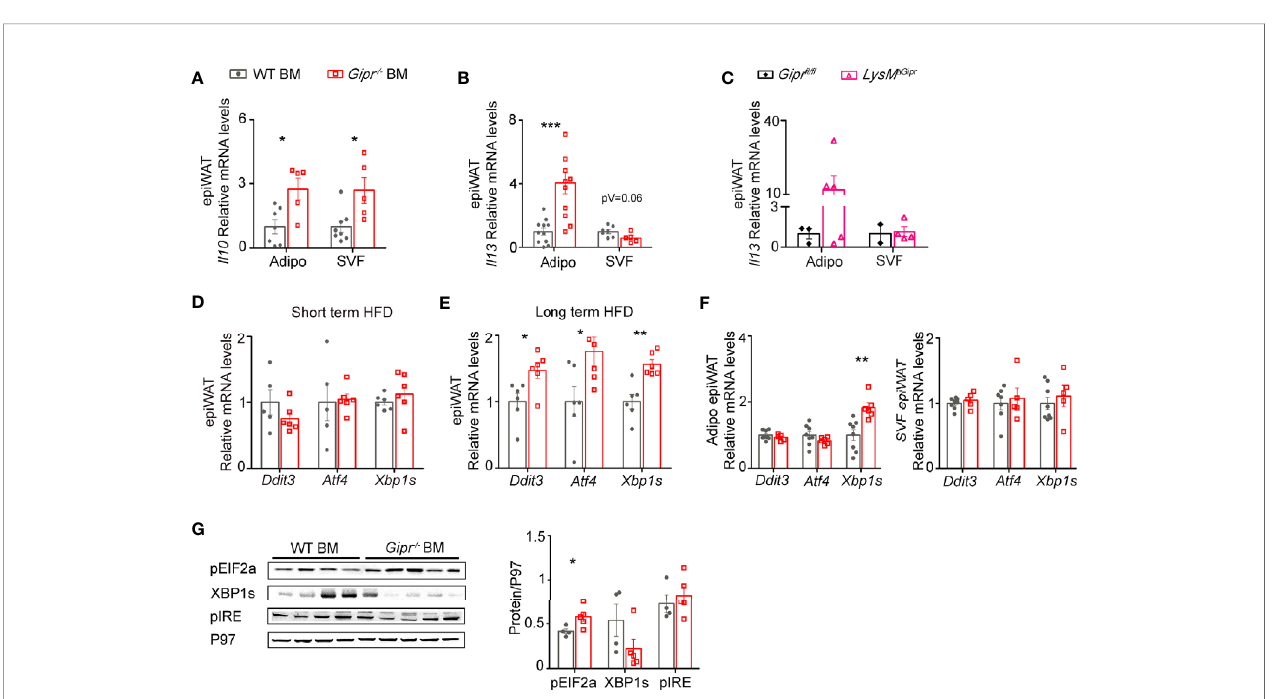
FIGURE 5 | Impairment of type 2 immune networks in Gipr -/- BM epiWAT involves adipocyte fraction cells. Expression of Il10 (A) and Il13 (B) in isolated adipocyte fraction and SVF in epiWAT of WT BM (gray circles) or Gipr -/- BM (red squares) mice after 14 weeks of HFD as determined by qRT-PCR analysis. (C) qRT-PCR assessment of the expression of Il13 in isolated adipocyte fraction and SVF in epiWAT of LysM D Gipr (pink open triangles) and Gipr fl / fl (black rhombus) obese mice after 14 weeks of HFD. (D , E) qRT-PCR assessment of the expression of indicated genes in epiWAT at shorter (5 weeks) and longer (14 weeks) HFD-regimes respectively, normalized to Rplp0 . (F) qRT-PCR assessment of the expression of indicated genes in isolated adipocyte fraction and SVF in epiWAT of WT BM or Gipr -/- BM mice after 14 weeks of HFD. (G) Expression of phosphorylated EIF2 (pEIF2 a ), spliced form of XBP1 (XBP1s) and phosphorylated IRE (pIRE) in epiWAT from WT BM (n=4) and Gipr -/- BM (n=5) mice, as assessed by immunoblot analysis and was quanti fi ed using P97 as loading control (for pEIF2 a , P=0.04, for XBP1s, p=0.15 and for pIRE, P=0.54), with densitometry presented below. Data are analyzed by unpaired, two-tailed t -test, and results are presented as mean ± SEM with signi fi cance: *p < 0.05, **p < 0.01, ***p < 0.001. Data in panel (A) are from two independent experiments, and in (B – F) are from one experiment. Adipo, adipocyte fraction; SVF, stromal vascular